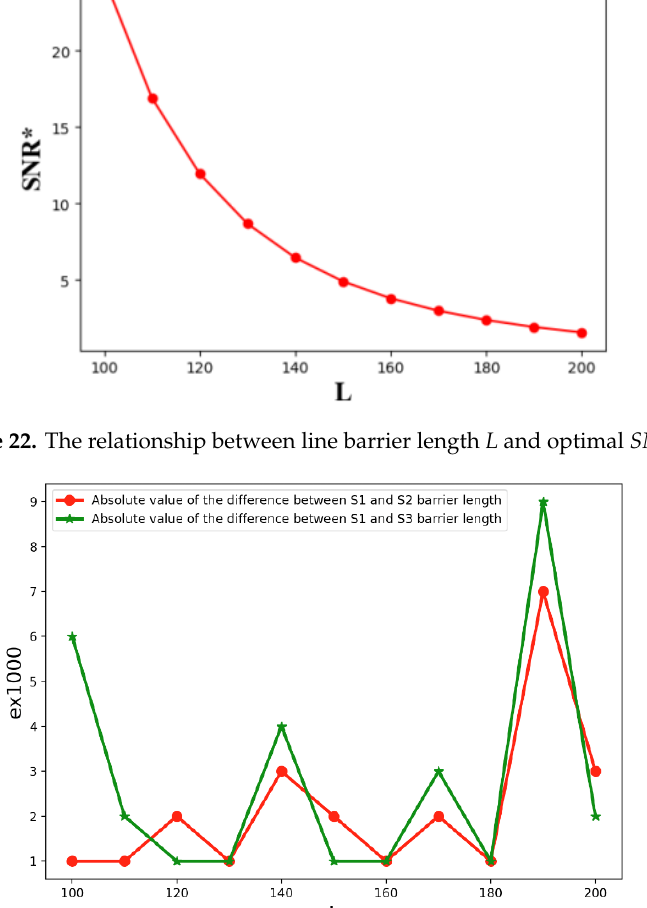
Figure 23. The Variation deviation of barrier length of difference placement orders: S 1 , S 2 , and S 3.